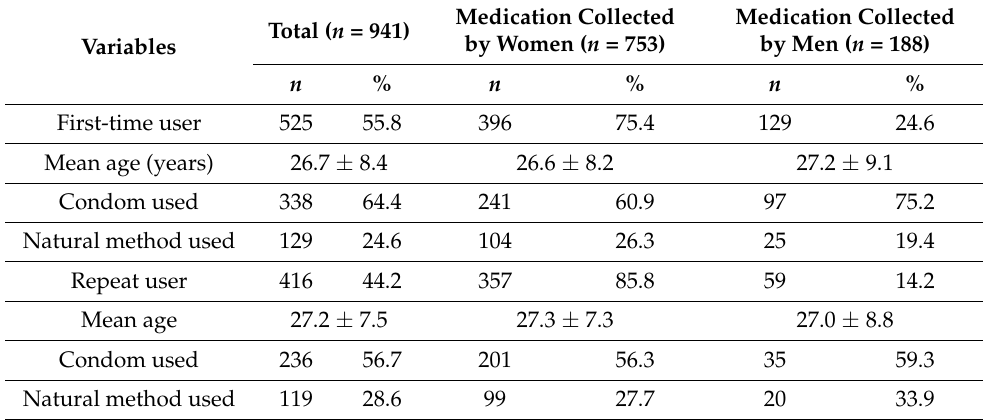
Table 1. Profile of users who used EC in Catalonia during the period